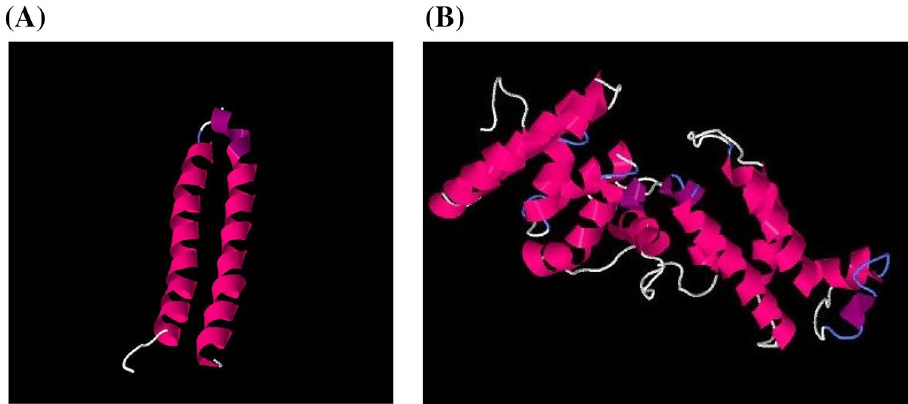
Figure 3. In silico predicted 3D models for c- ( A ) and a-subunits ( B ) of F0F1ATPase of Streptococcus pneumoniae created with Bioserf v.2.0. Alpha helices are colored in pink. All 31 optochin-resistant S. pneumoniae strains analyzed and the reference strains ATCC BAA-255 and ATCC 49619 generated identical models for both subunits.